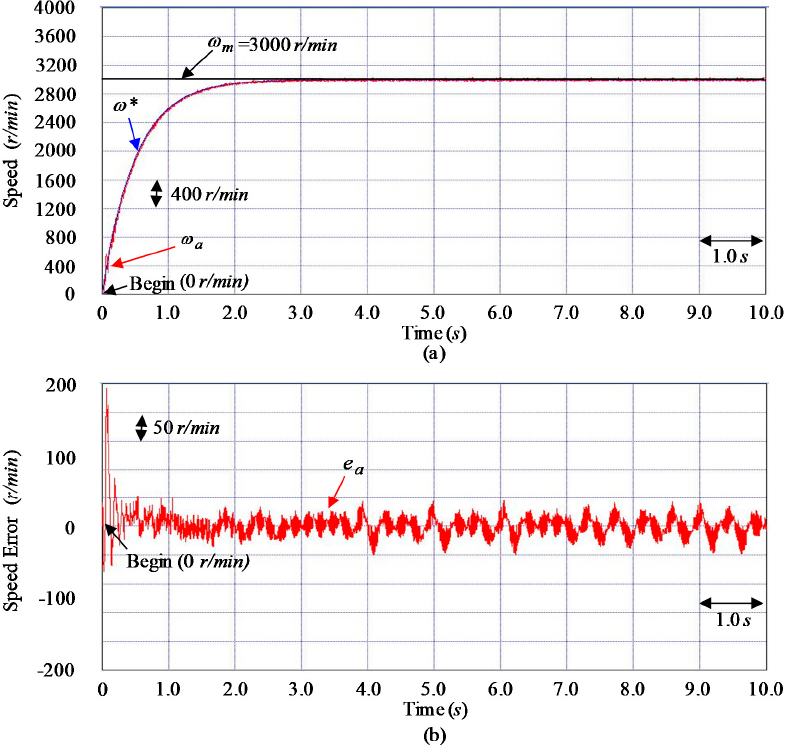
Figure 7. Tested results for the SIM expelling CVT organized system at the tested Event E2 case by using the controller CT1: ( a ) speed response, ( b ) speed discrepancy response .